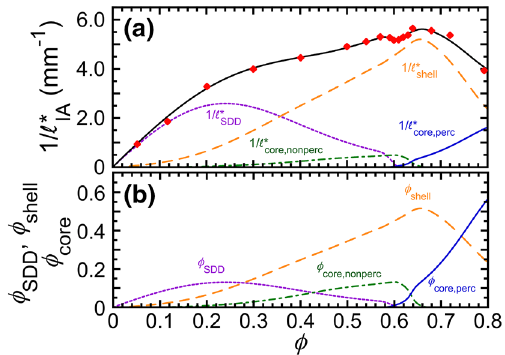
Figure 4. Principal component analysis of 1 /ℓ ∗ IA (φ) using the extended decorated core-shell network (E-DCSN) model (see text). ( a ) Measured 1 /ℓ ∗ IA (φ) (red diamonds) from Fig. 1. Fit: Eq. (1) (black solid line). Inferred φ -dependent scattering contributions from: surface decorating droplets ( 1 /ℓ ∗ SDD , purple dotted line), shell droplets ( 1 /ℓ ∗ shell , orange dashed line), non-percolating core droplets ( 1 /ℓ ∗ core,nonperc , green dashed-dotted line), and percolating core droplets ( 1 /ℓ ∗ core,perc , blue solid line). ( b ) Component droplet volume fractions: φ SDD , φ shell , φ core,nonperc , and φ core,perc [line colors and types as in part